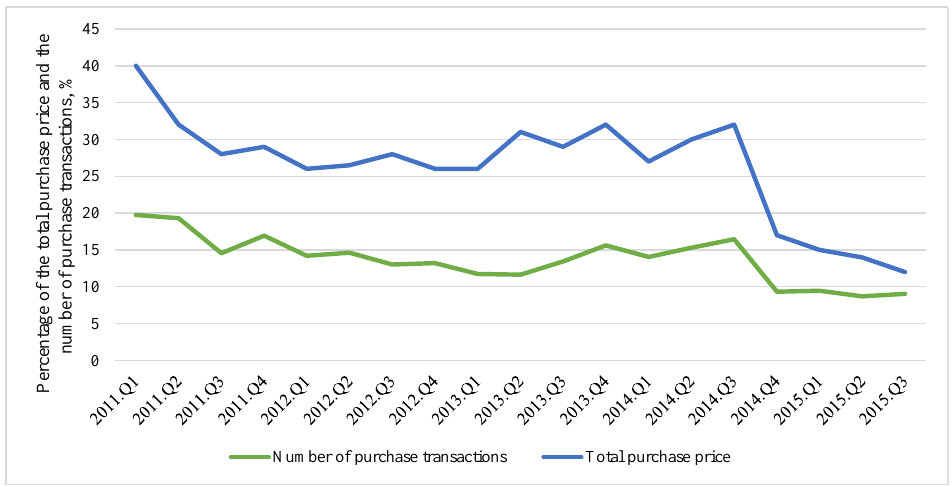
Fig. 1 . Dynamics of the percentage of the total purchase price